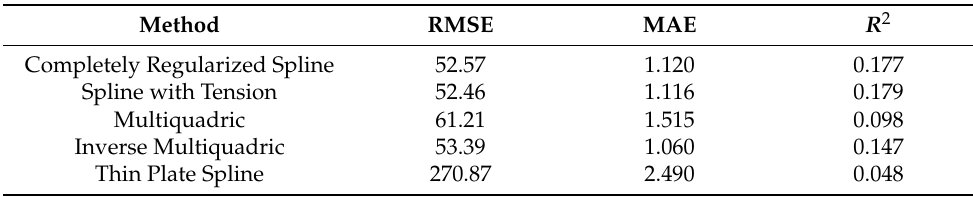
Table 3. Error values and R 2 for the five applied RBF methods.